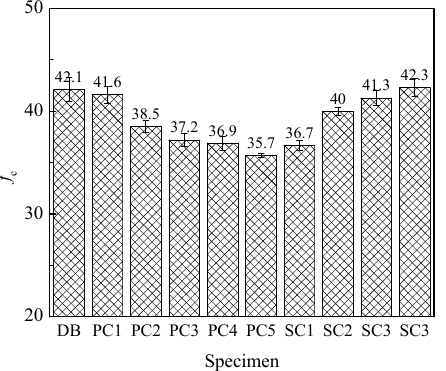
Figure 5. Peak stress and its error diagram.